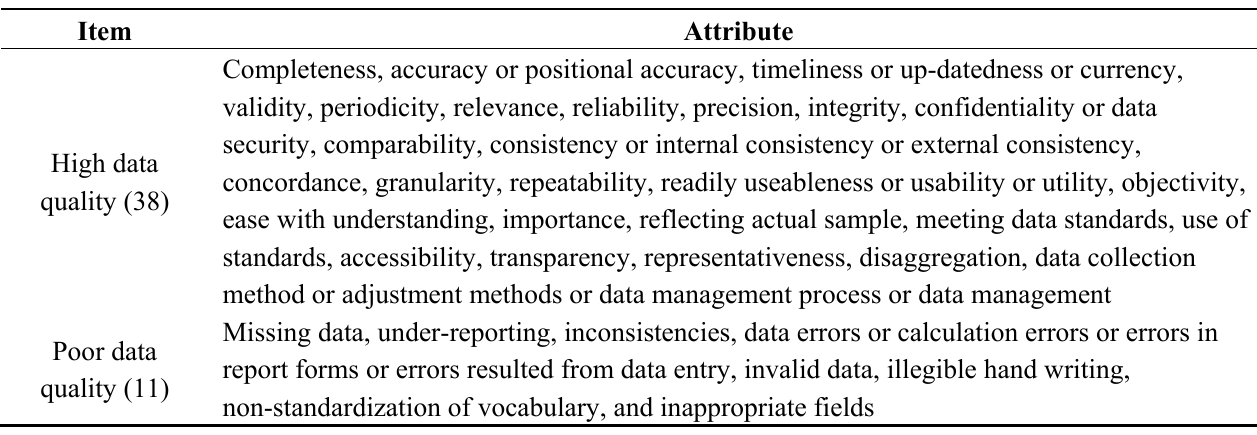
Table 2. Attributes of data